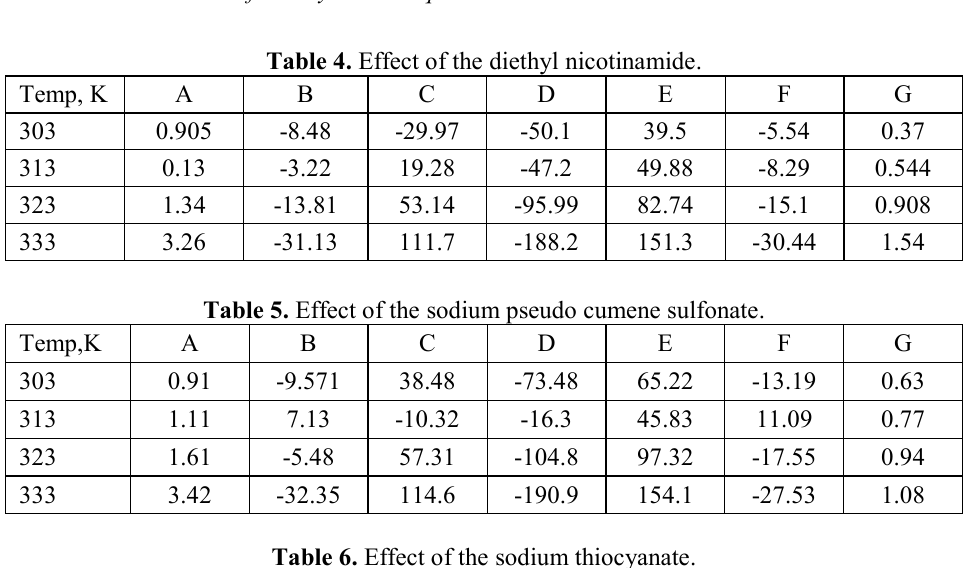
Table 3. Setschenow constant [K